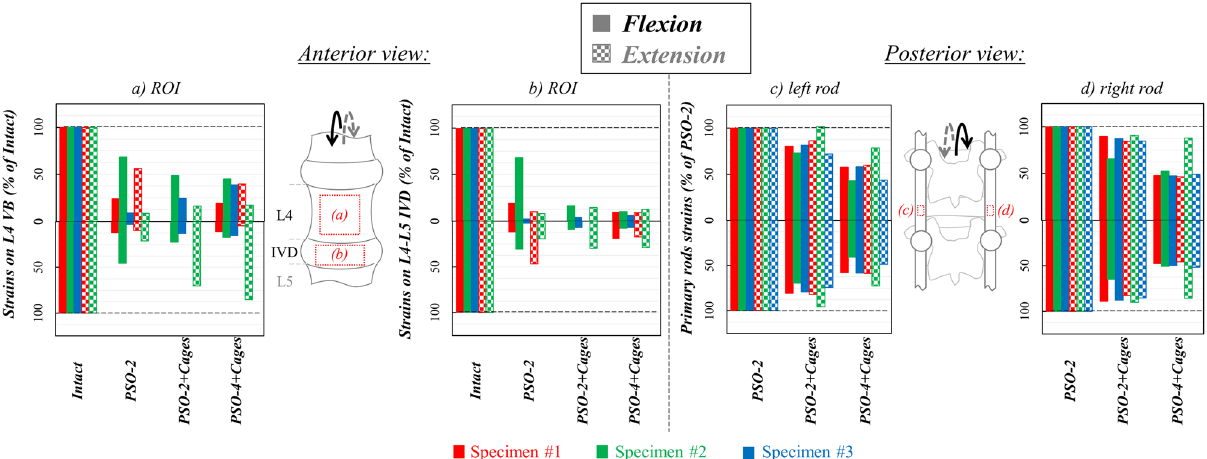
Figure 4. Flexion/extension: Normalized strain values on the regions of interest (ROI) on L4 VB ( a ) and on the L4–L5 IVD ( b ) and normalized primary rods strains both on the left ( c ) and right ( d ) rods following PSO at L4 and posterior instrumentation with 2 primary-rods (“PSO-2”), with 2 rods and supplementary intervertebral cages (“PSO-2 + Cages”) and with supplementary accessory rods and intervertebral cages (“PSO-4 + Cages”). Supplementary Tables provide quantitative strain data either for each specimen both anteriorly and posteriorly.